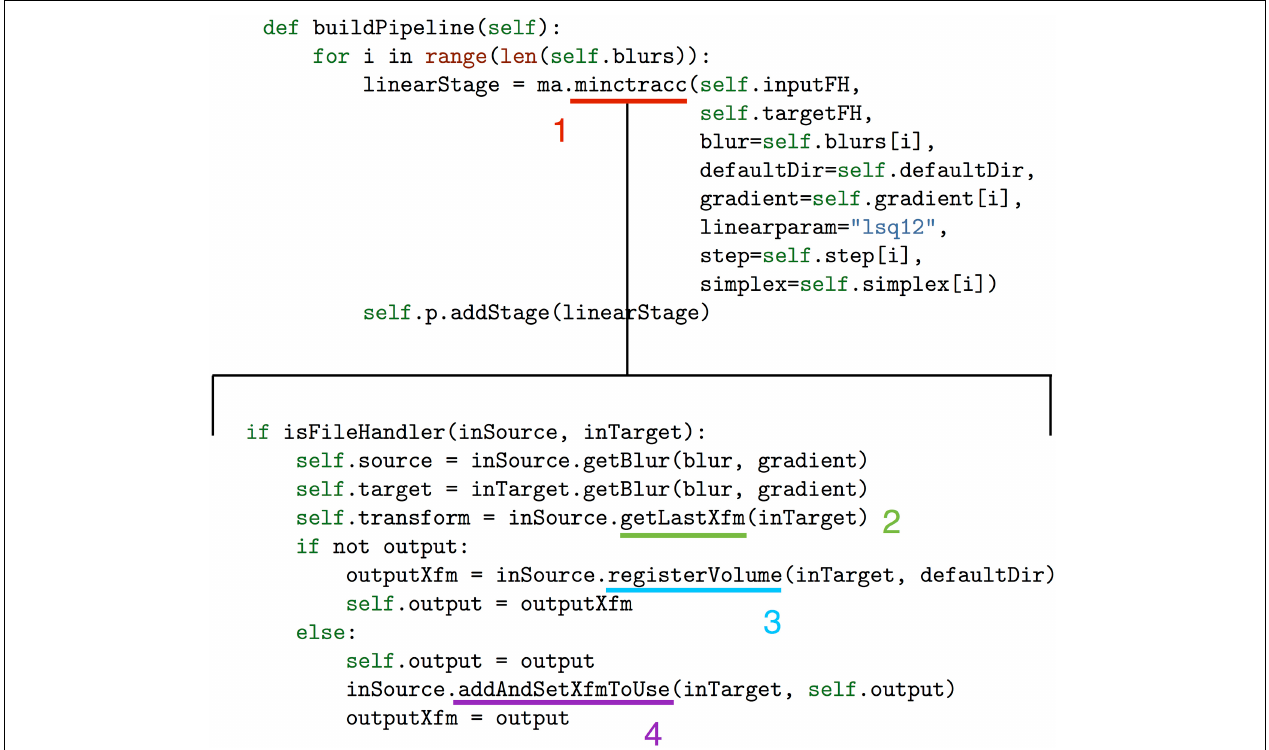
FIGURE 4 | The buildPipeline function that is part of one of the Pydpiper modules (top) and a portion of the highlighted minctracc class (bottom). The minctracc class (1), called multiple times in the for loop, is expanded to show details about how the file handling classes operate. Each time minctracc is called, getLastXfm (2) finds the last transform between input and target and uses it as the input transform for the current function call. If no previous transform exists, an appropriate default is set based on the specified registration parameters.